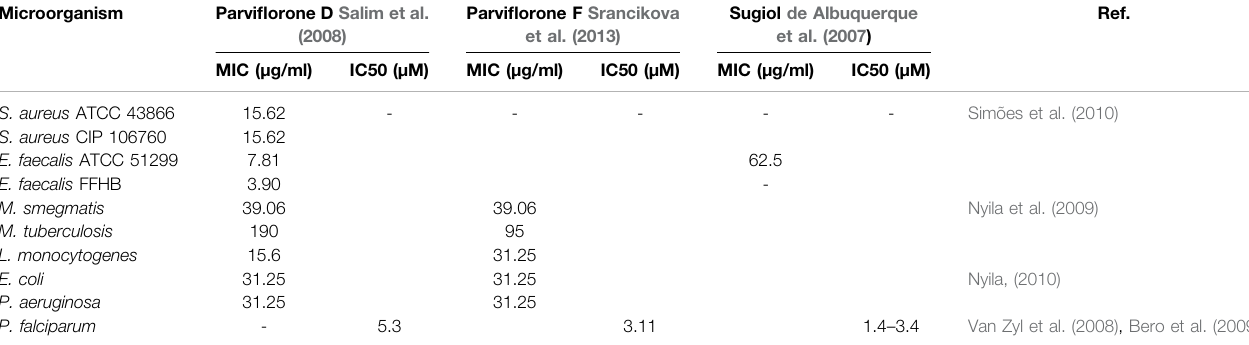
TABLE 2 | MICs and IC 50 values of the compounds Parvi fl orone D, Parvi fl orone F and Sugiol against different tested microorganisms. Microorganism Parvi fl orone D Salim et al.